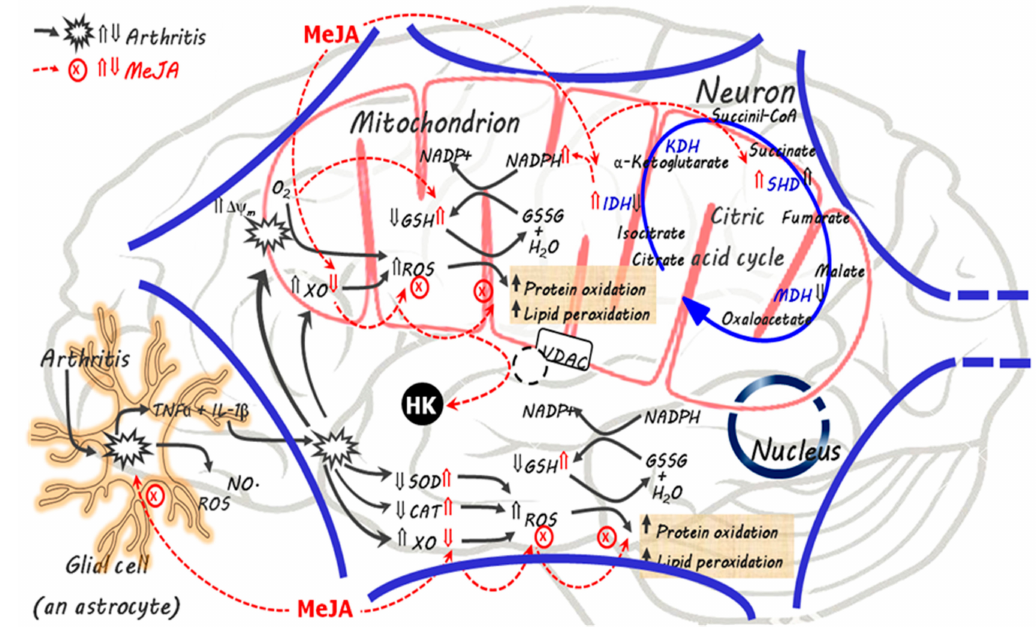
Figure 7. Events modifying inflammation and the oxidative state in the brain of rats with adjuvant-induced arthritis and the actions of methyl jasmonate (MeJA). The scheme is based mainly on the results of the present study and literature data. The symbol ⇑ means up-regulation and ⇓ means down-regulation. Black arrows indicate events in the absence of MeJA and red arrows indicate the e ff ects of MeJA. Abbreviations: TNF- α , tumor necrosis factor alpha; IL-1 β , interleukin 1 β ;